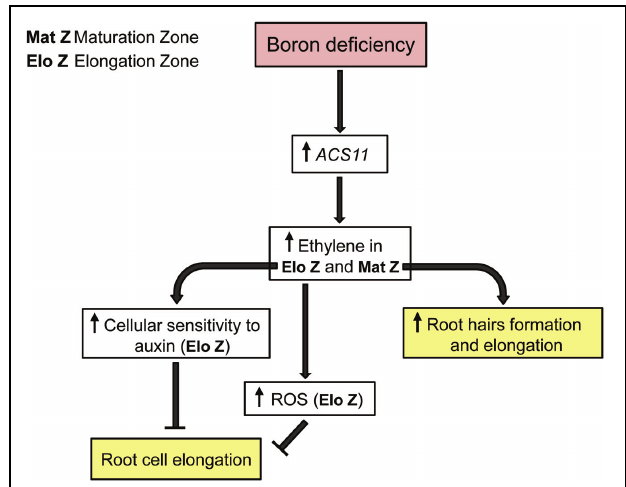
FIGURE 1 | Proposed model for short-term response of the primary root of Arabidopsis thaliana plants to B deficiency. For more details see the